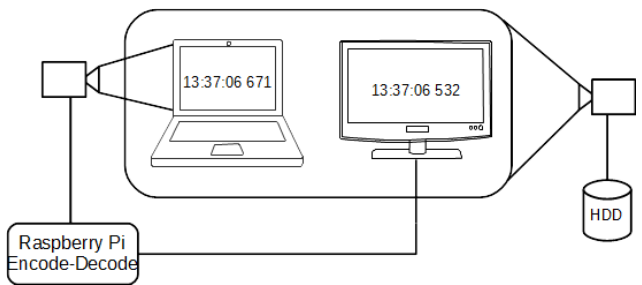
Figure 4. Measurement setup without network.